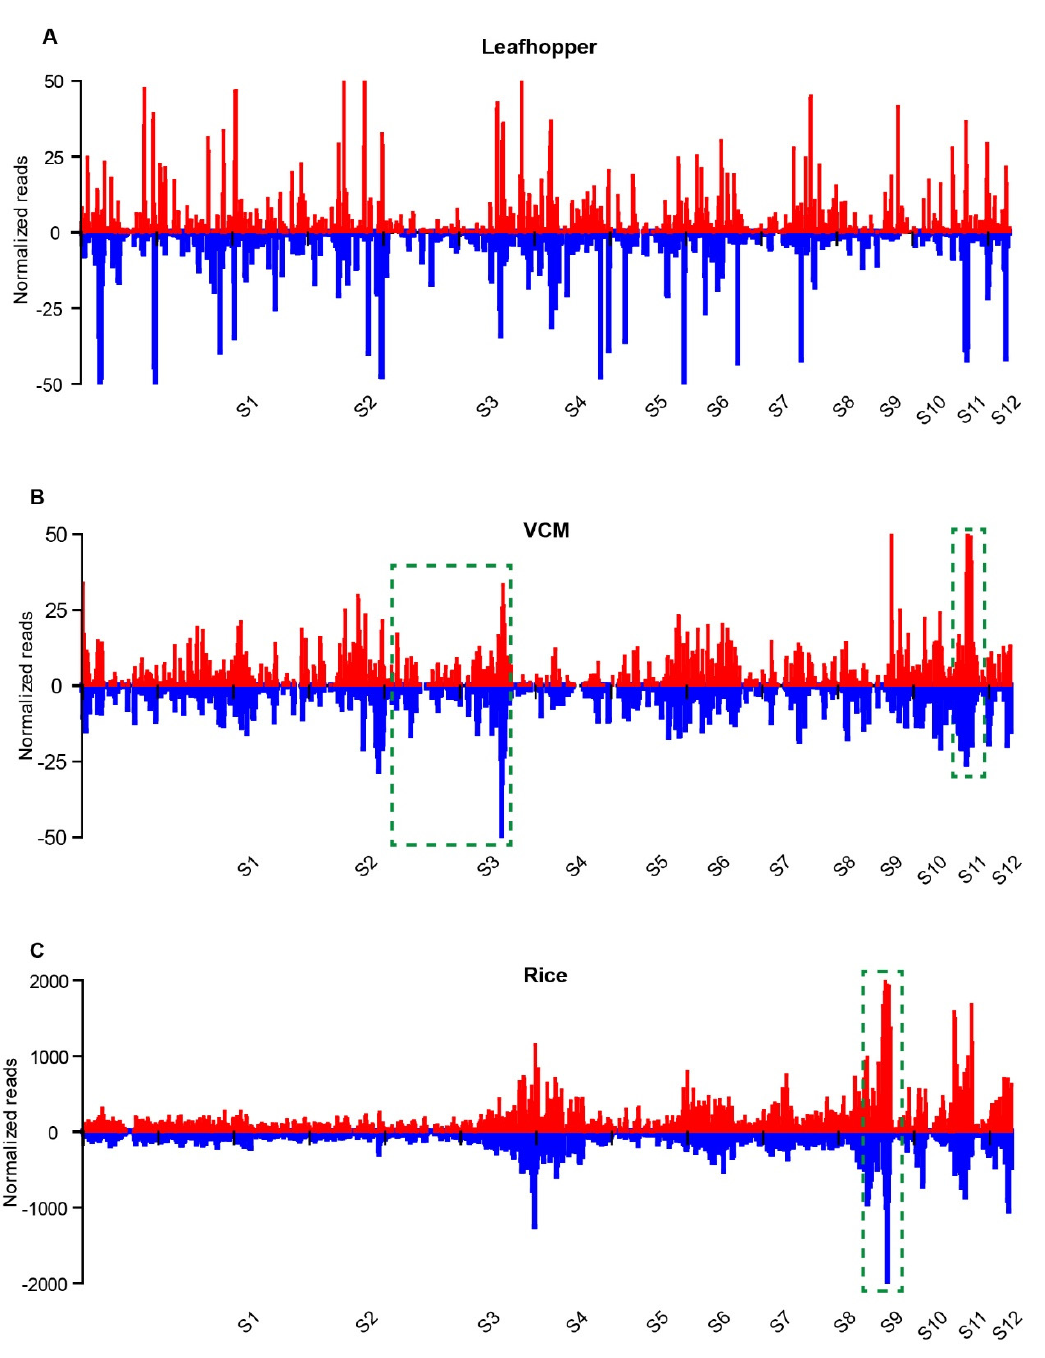
Figure 2. Genomic view of RDV vsiRNAs from RDV-infected leafhoppers ( A ), VCMs ( B ), and rice plants ( C ). vsiRNAs per million total sequenced small RNAs are plotted against the positive ( red ) or negative ( blue ) strands of the 12 RDV genomic RNAs (S1–S12) using a 20-nt window. Green boxes on S3 and S11 in VCM and S9 in rice represent the hotspots of vsiRNAs clustered at the terminal regions of genomic RNAs.